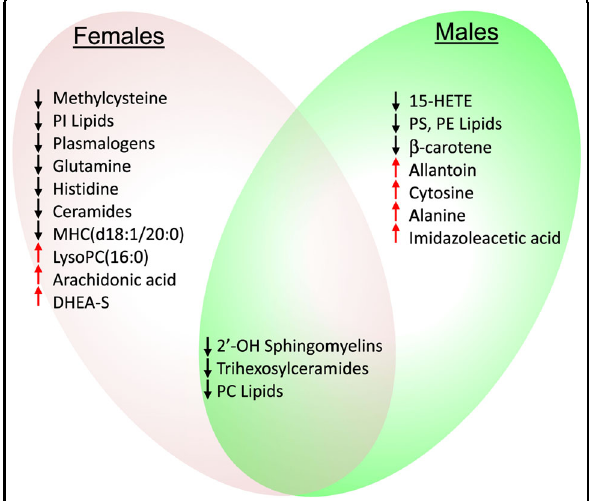
Fig. 4 Venn diagram of shared and gender-speci fi c predictors of recurrence. Red arrows indicate an increased, and black arrows indicate a decreased concentration was associated with risk of recurrence of depression. rrMDD subjects were followed prospectively for 2.5 years: n = 42 females (24 with recurrence, 18 no recurrence), 20 males (11 with recurrence, 9 no